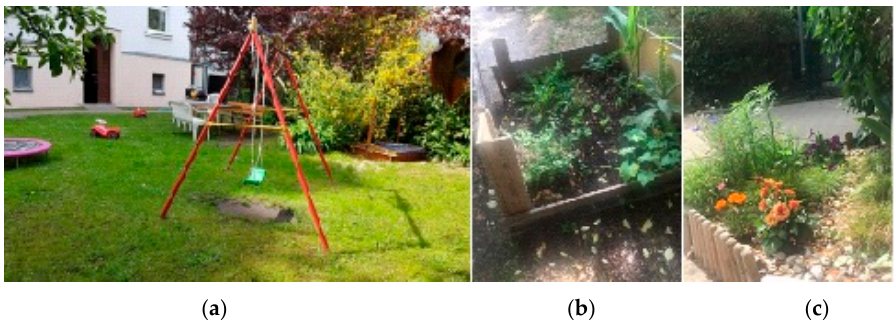
Figure 7. An innovative concept in greening areas near the kindergartens of Leipzig: ( a ) nature-oriented playground, ( b ) flower and vegetable beds, and ( c ) flower beds in water-sensitive design. Photos: D. Dushkova.